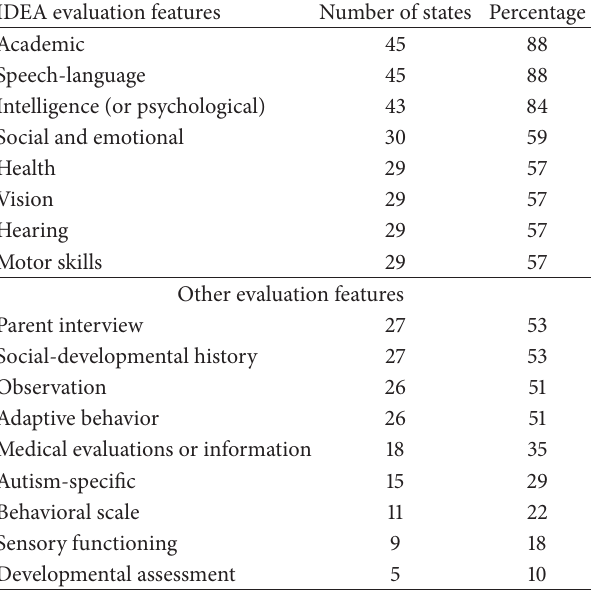
Table 2: Features of state education agency evaluation procedures for